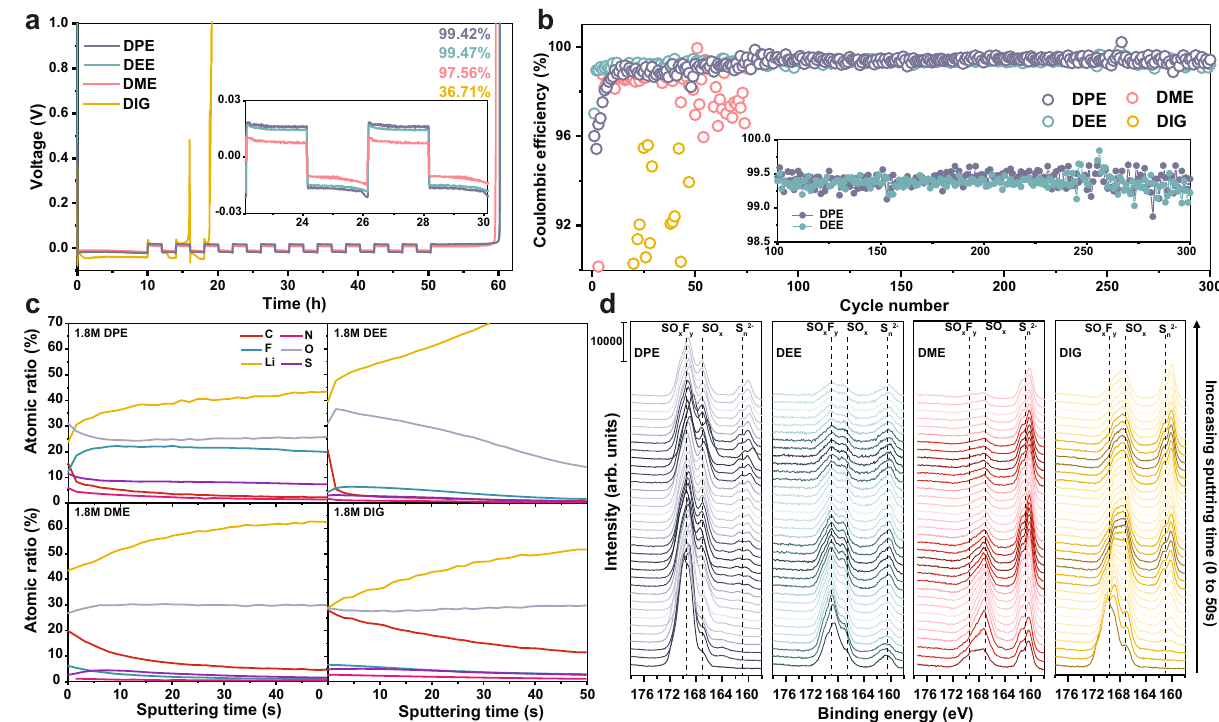
Fig. 5 | Investigations on the stability of the electrolytes with a Li metal elec- trode. All electrolytes contain 1.8M LiFSI salt. All tests were performed at 25°C. a Coulombic ef fi ciency determined by modi fi ed Aurbach method under 0.5mA/ cm 2 currentdensity. b extendedlongcyclingofLi||Cucellswith0.5mA/cm 2 ,1mAh/